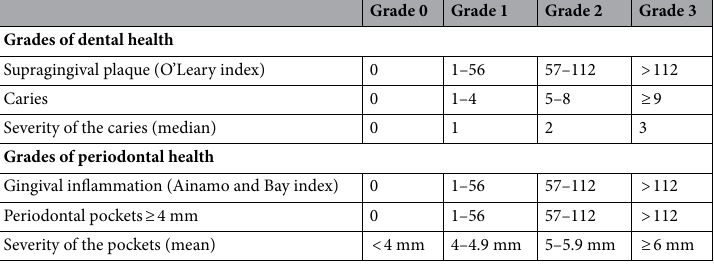
Table 1. Scale of overall oral health, involving grades of dental and periodontal